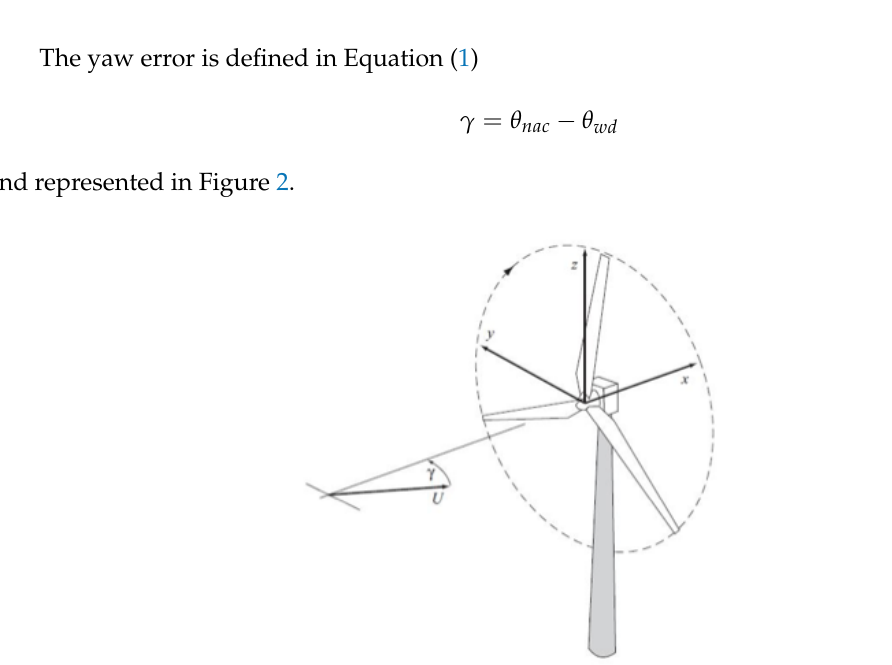
Figure 2. Representation of the yaw error γ